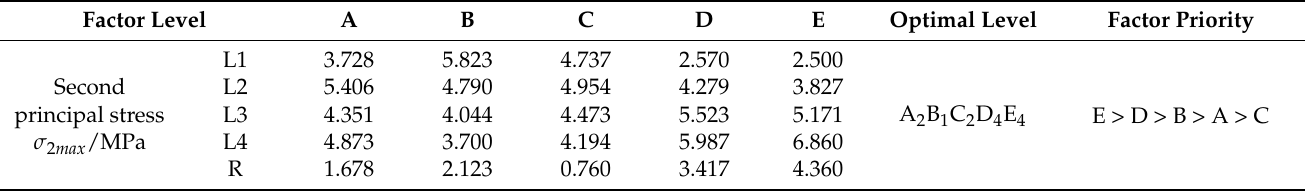
Table 5. Analysis of the degree of influence of various factors on the intermediate principal stress σ 2